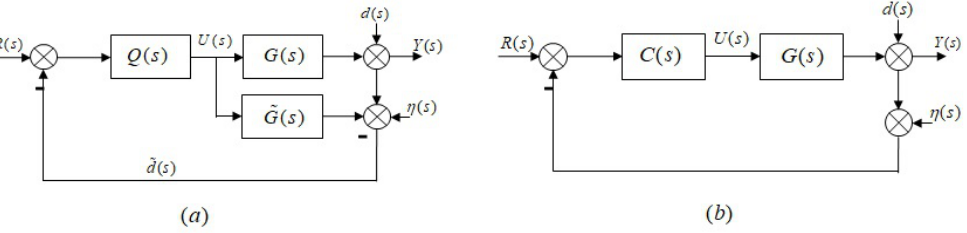
Figure 3. ( a ) IMC, ( b ) Classical control